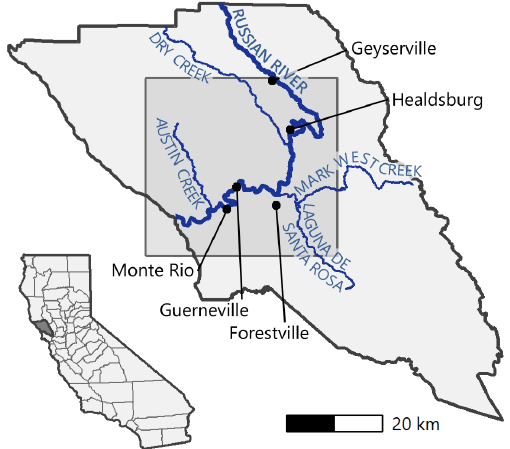
Figure 2. Map of Sonoma County. The shaded box indicates the study area, and the labels highlight notable hydrologic elements and riverside communities. A map of California with Sonoma County shaded in dark gray is included for geographic